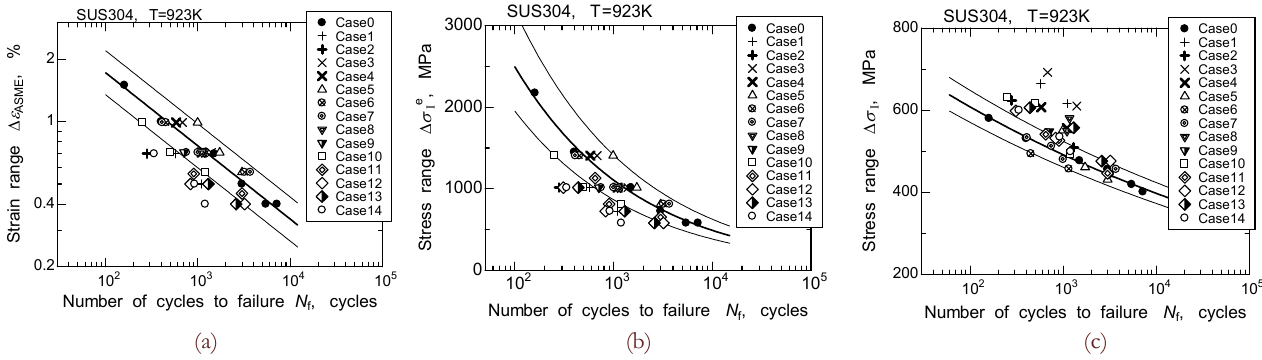
Figure 9: Correlation of non-proportional LCF lives with  ASME ,  I e and  I : (a)  ASME  N f , (b)  I e  N f , (c)  I  N f . Fig. 10 correlates the non-proportional LCF lives with  NP , where material constant,  , is set to 0.4.  NP correlates the